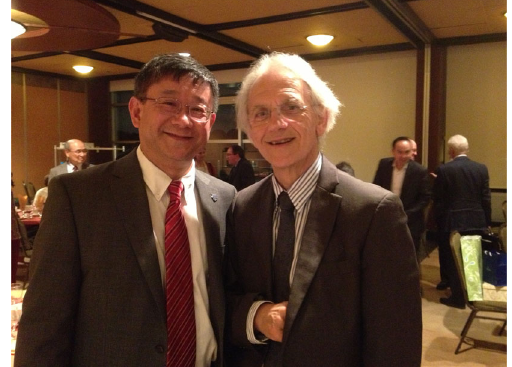
Three of four states, solid, gas, and plasma, have been used to generate THz waves. The use of liquids as THz sources is a real